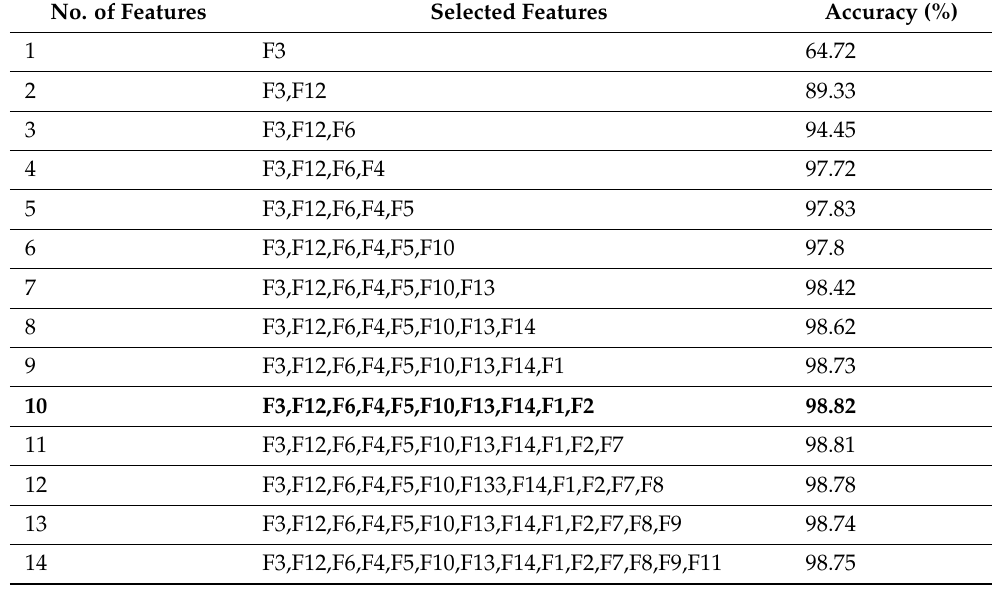
Table 9. Performance of fault detection using SFS with KNN (five-fold cross-validation).